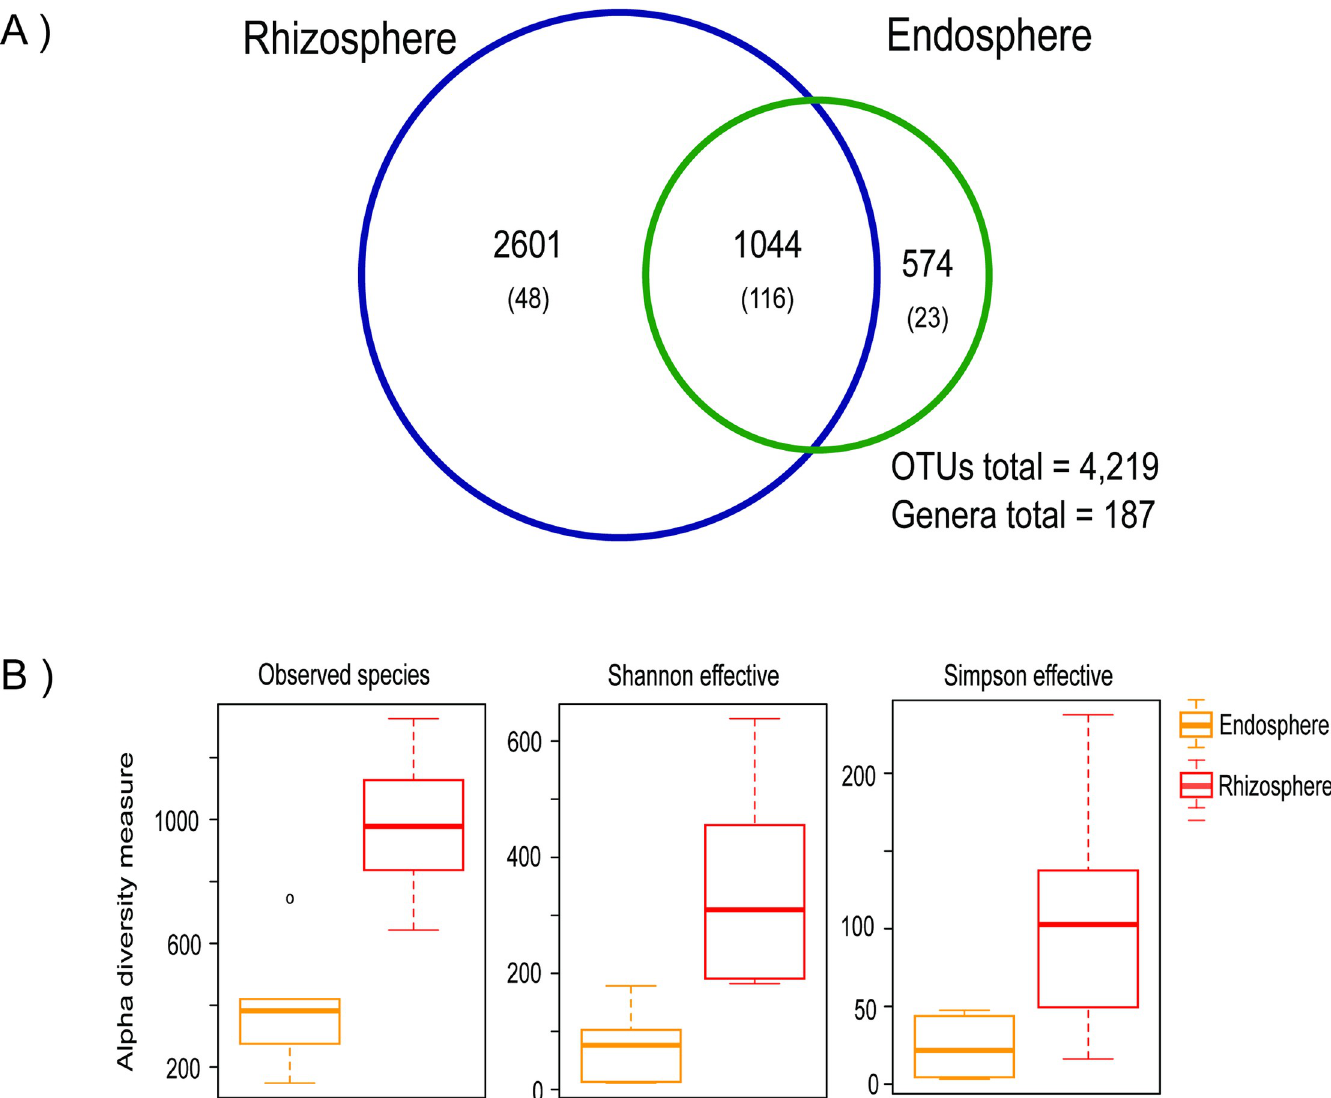
Fig 5. Differences of bacterial diversity between the endosphere and rhizosphere (set “Rhizosphere” comparison). A) Venn diagram showing the shared OTUs and genera (in parenthesis) between the endosphere and rhizosphere of the six Dioon samples. B) Distribution of alpha-diversity within the rhizosphere and endosphere as measured by observed species, Shannon and Simpson effective